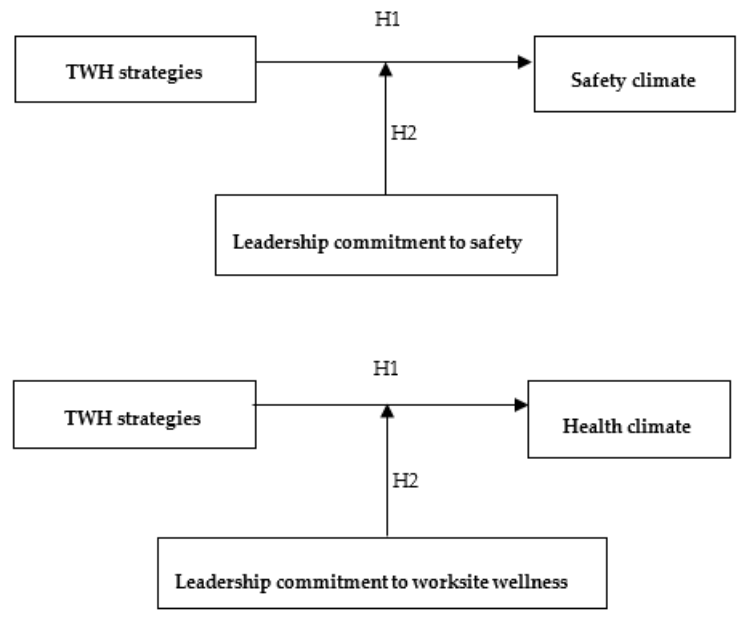
Figure 1. Hypothesized relationships between Total Worker Health ® (TWH) strategies (benchmarks).